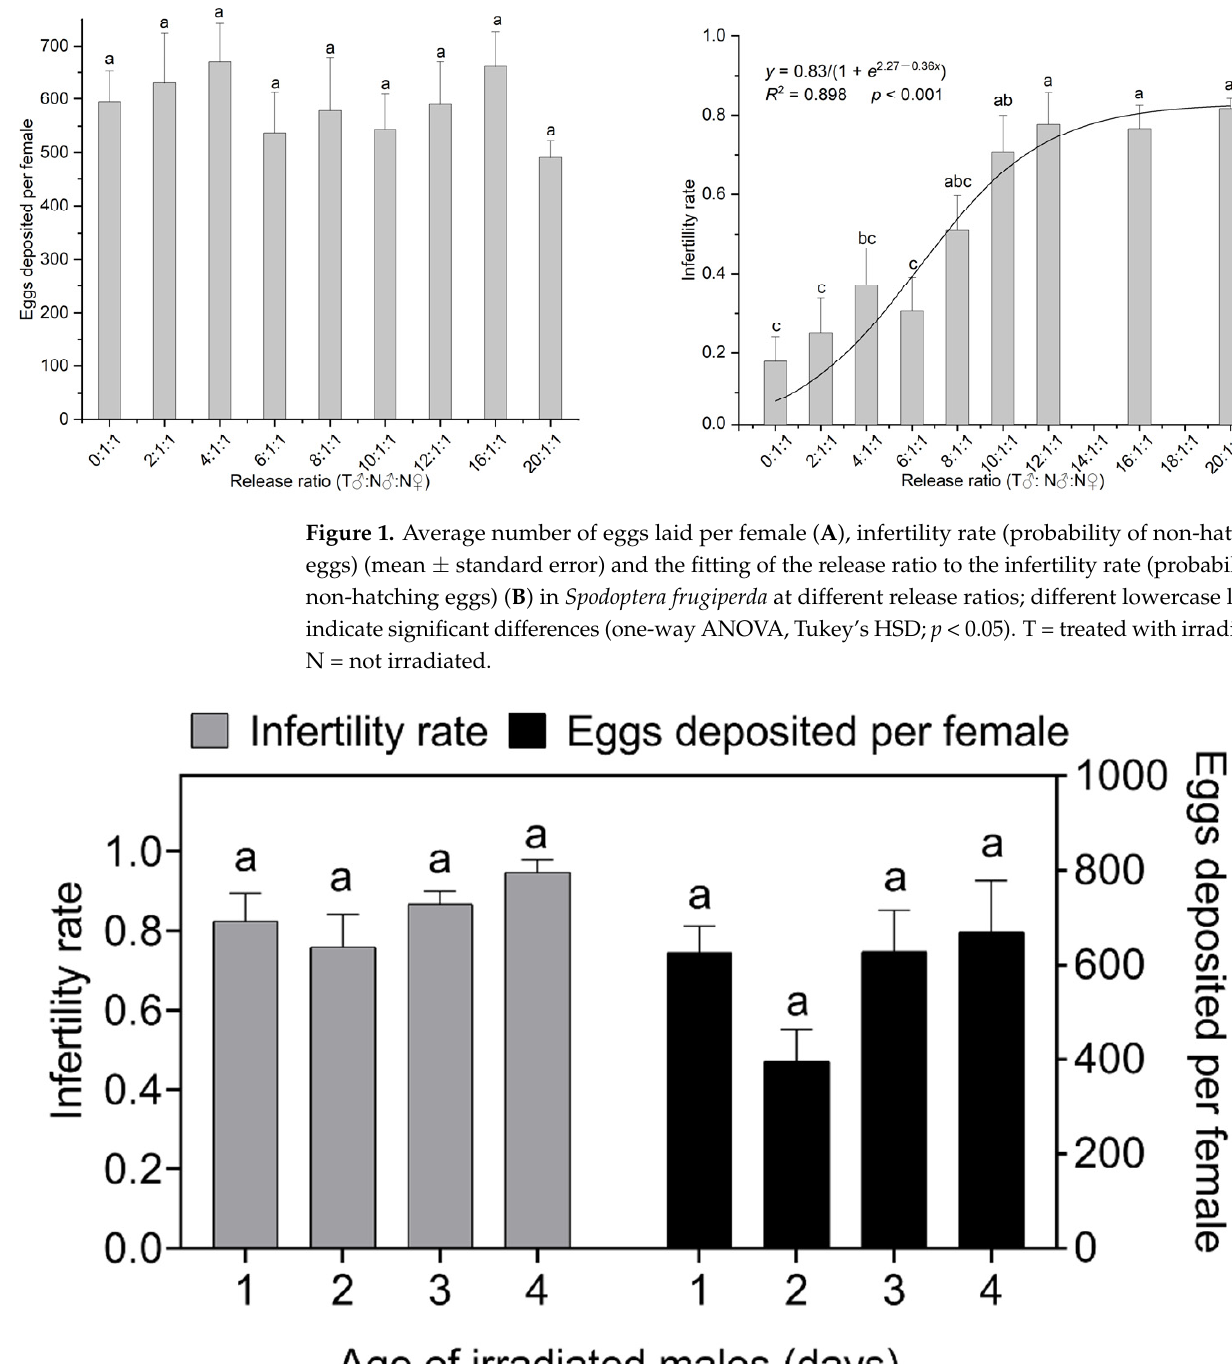
Figure 2. Effect of the ages of irradiated Spodoptera frugiperda males on egg production and the infertility rate (probability of non-hatching eggs). Data in the figure are the mean ± standard error; different lowercase letters indicate significant differences (one-way ANOVA, Tukey’s HSD; p < 0.05). In this experiment, the irradiated male: non-irradiated male: non-irradiated female ratio = 12:1:1, where both the non-irradiated male and the female were 1 day old.